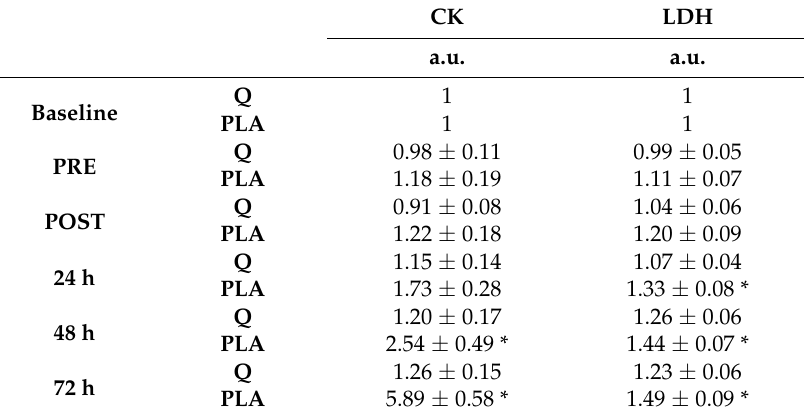
Table 3. Mean plasma creatine kinase (CK) and lactate dehydrogenase (LDH) values measured in Q and PLA conditions at baseline (BASE), before (PRE), immediately (POST), 24 h, 48 h and 72 h after the eccentric